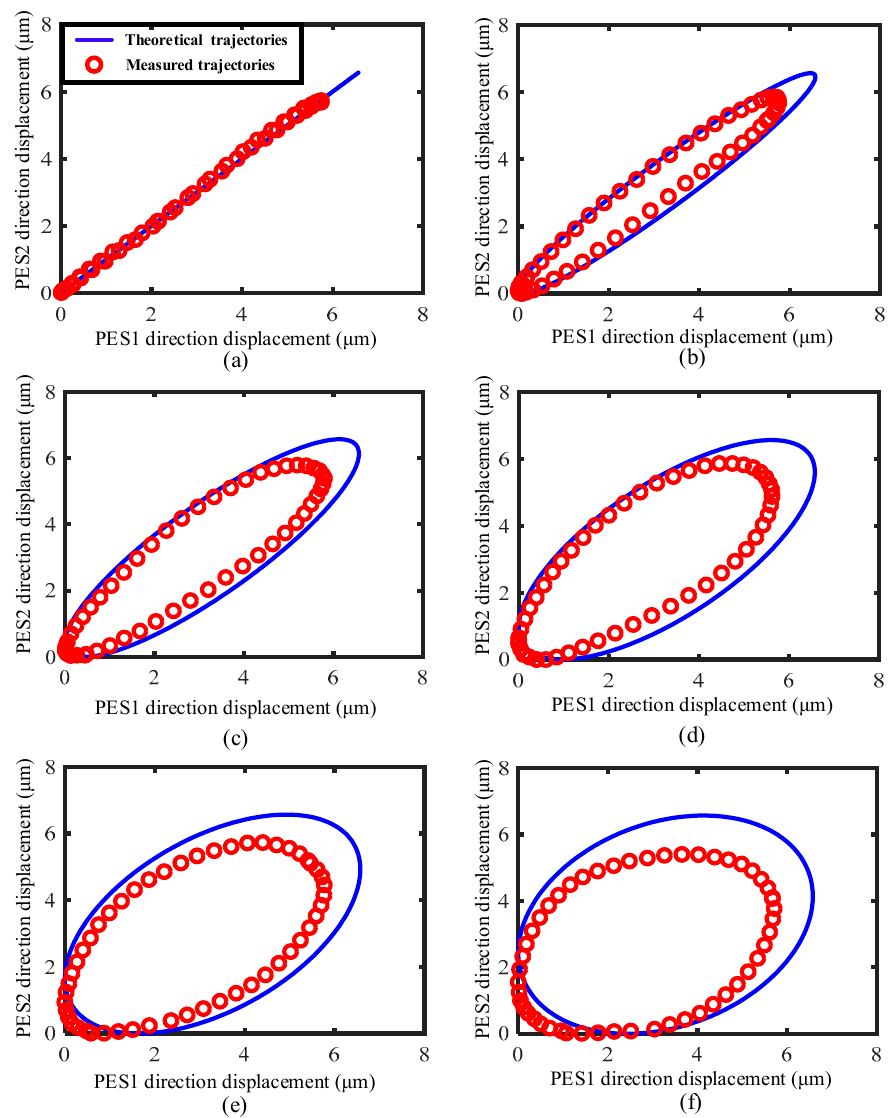
Figure 14. Comparison of the measured and theoretical motion trajectories of the output end of the flexure hinge mechanism under different phase differences: ( a ) 0°, ( b ) 15°, ( c ) 30°, ( d ) 45°, ( e ) 60°, and ( f ) 75°.